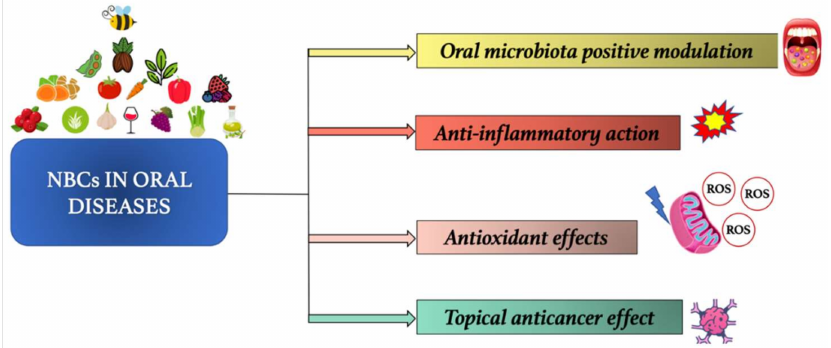
Figure 2. Natural bioactive compounds (NBCs) main actions in oral